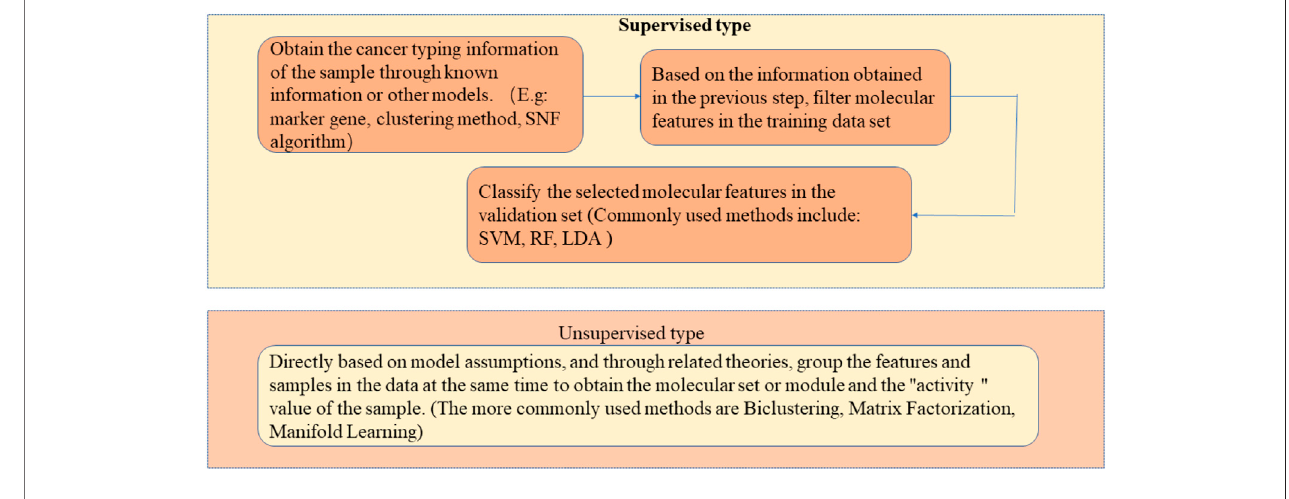
FIGURE 1 | Method for mining cancer molecular features.